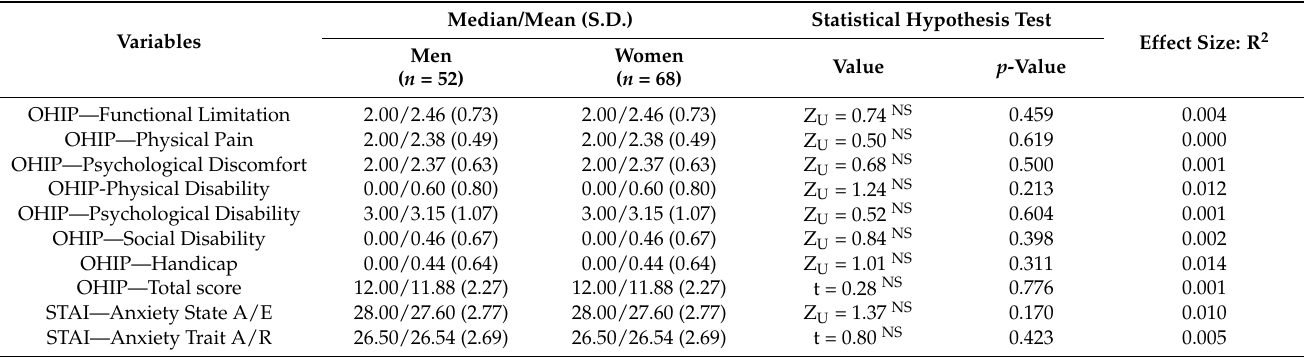
Table 3. Inferential Analysis. Intergroup comparison of OHIP-14 and STAI variables based on sex ( n = 120).